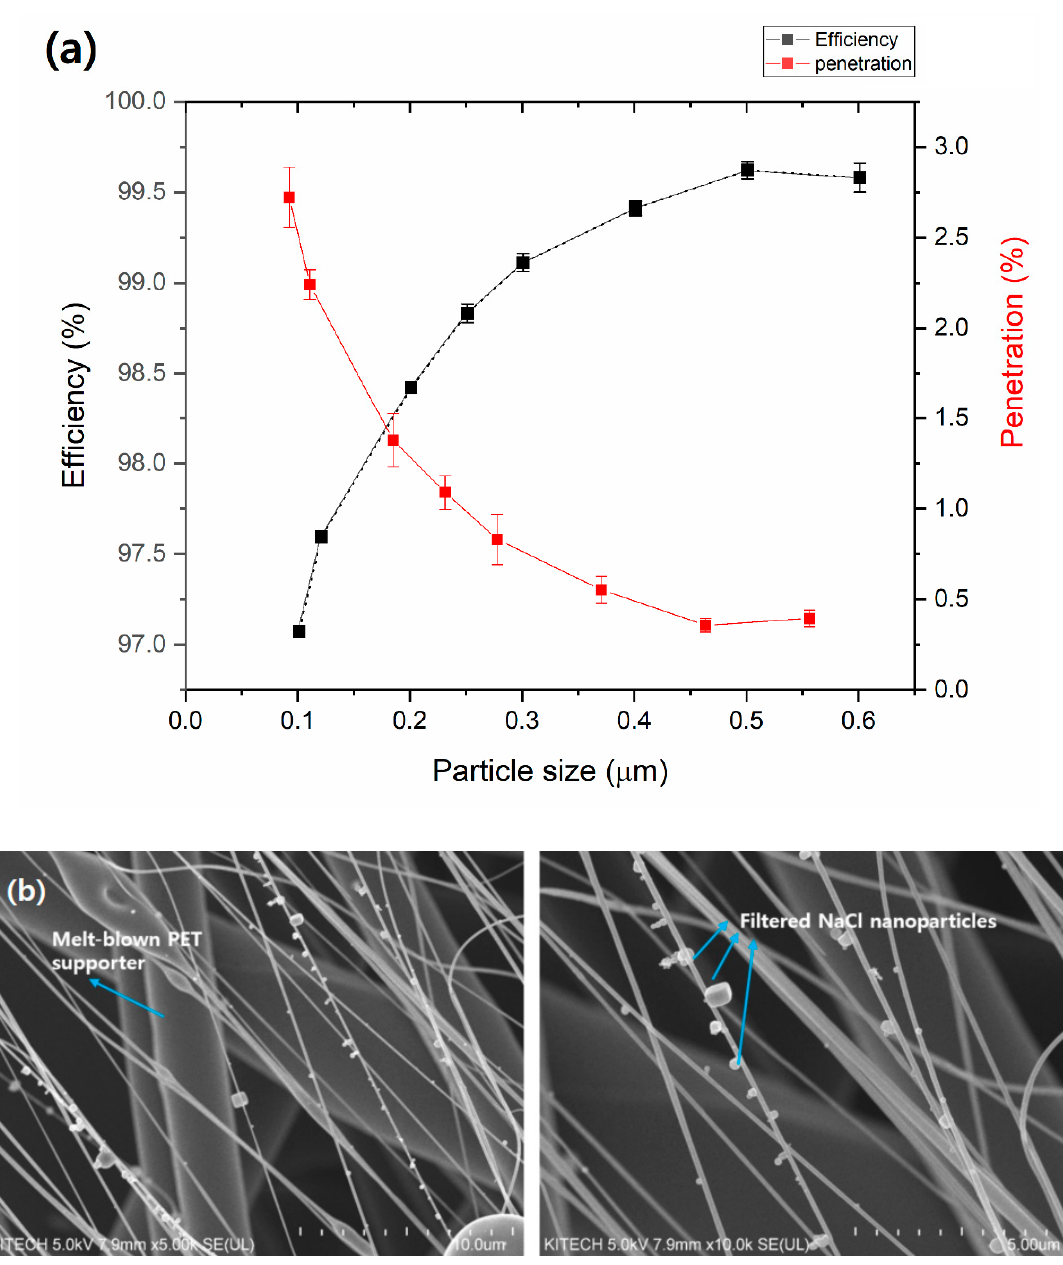
Figure 5. ( a ) Diagrams of the filtration efficiency (%) and air penetration (%) of 10 wt% TiO 2 -CA nanofiber webs, and ( b ) captured NaCl particles (represented as PMs) on TiO 2 -CA nanofibers.